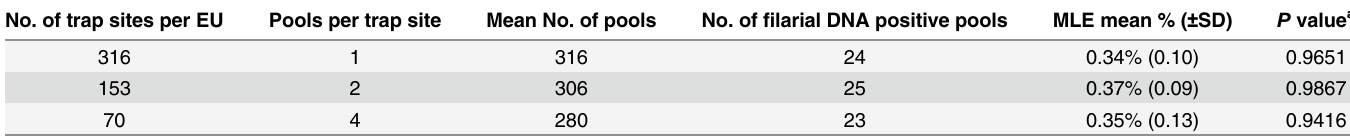
Table 3. Analysis of molecular xenomonitoring results using pools of Culex quinquefasciatus in Galle Public Health Midwife (PHM) areas. No. of trap sites per EU